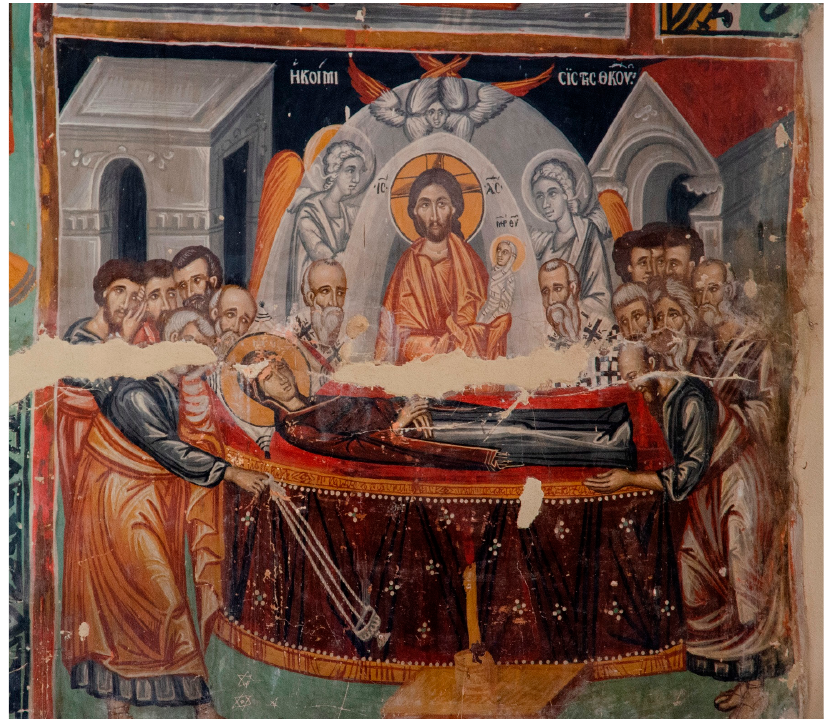
Figure 9. Dormition of the Theotokos , wall painting, 1514, The Church of the Archangelos Michael, or Panagia Theotokos, Galata, Cyprus. (Photo credit: Angel Yordanov, TerraByzantica ).